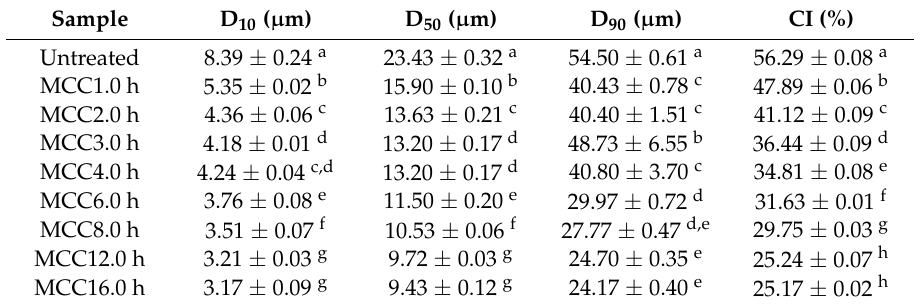
Table 2. Particle size distribution and crystallinity index (CI) of microcrystalline cellulose samples.